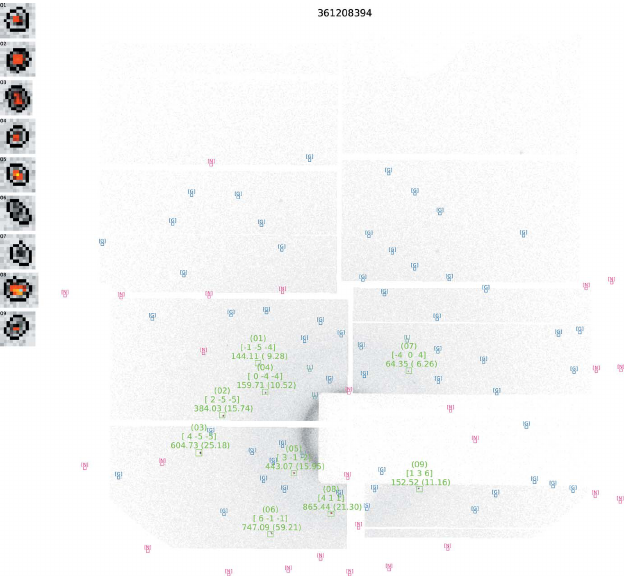
Figure 7 Data Frame 1 after the integration process. Reflection indices are given above the spot positions along with the calculated spot intensities. Nine spots have been integrated, and the integration boxes with the integrated spots are shown in the left corner. By comparing with Fig. 3, it becomes apparent that spots can be included in the integration even if they were not found during the initial spot finding process (spot numbers 06, 07 and 09). This is because all positions corresponding to symmetry-allowed reflections are searched for peaks.